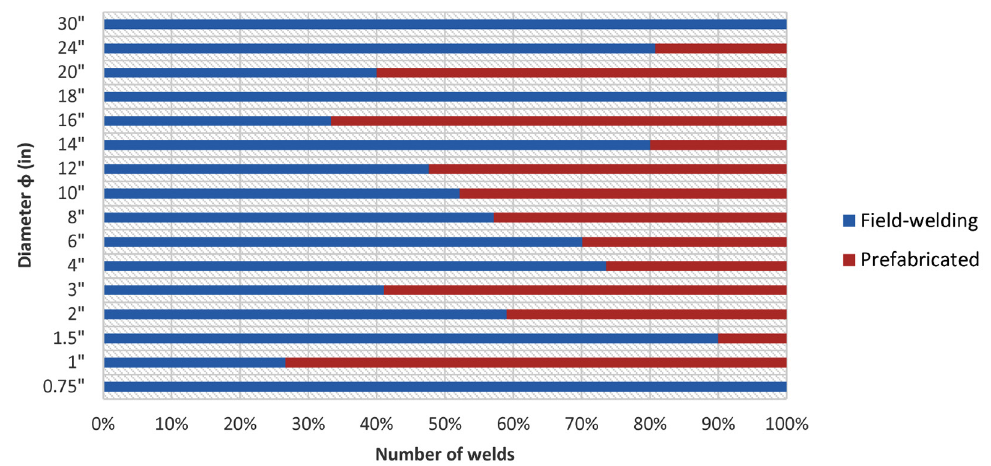
Fig. 4. Comparison of the number of welds by diameter between field-welding and prefabricated-welding from the 3D BIM